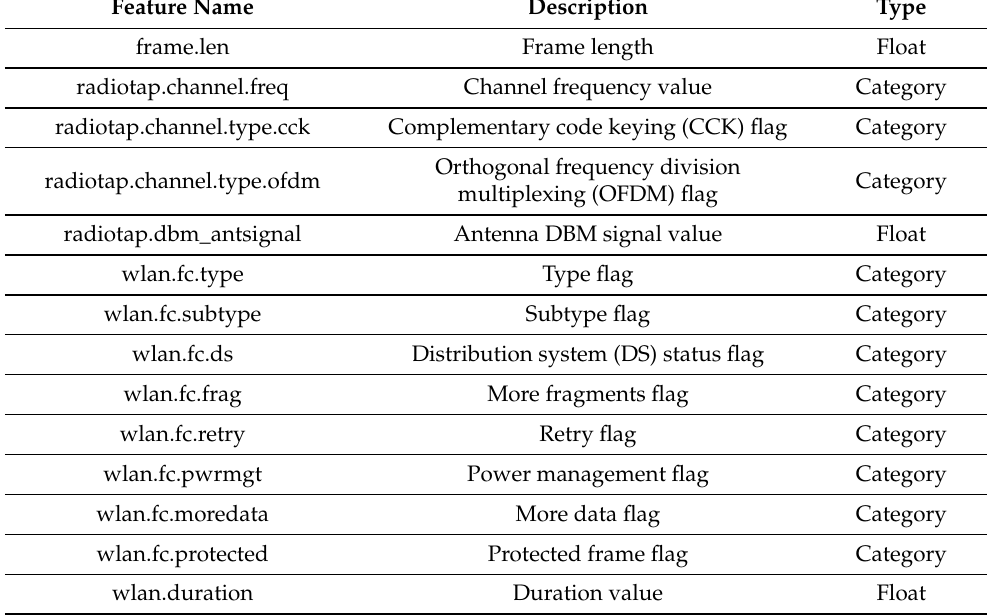
Table 1. Features used and their descriptions and